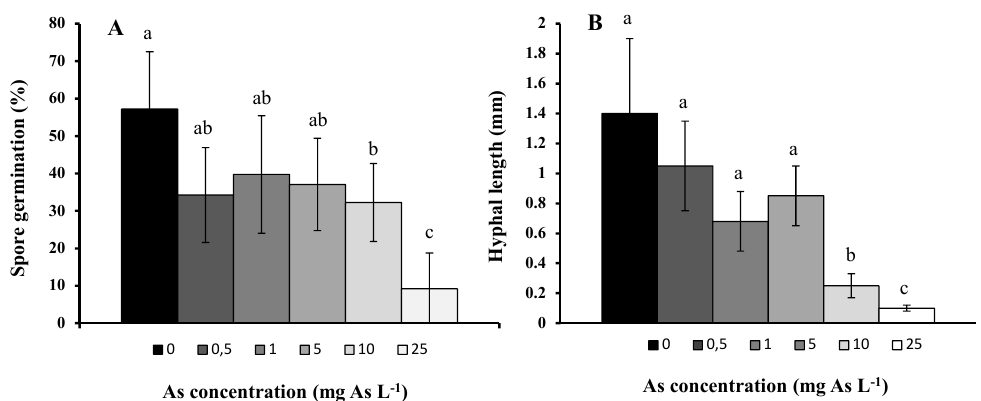
Figure 4. ( A ) Effect of As on spore germination in R. intraradices ; ( B ) effect of As on the hyphal length of R. intraradices. Different letters indicate significant differences determined by Tukey’s test ( p < 0.05).